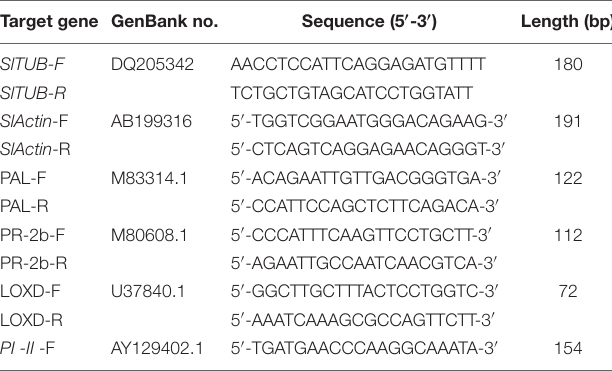
TABLE 1 | Overview of the target genes used in this study, showing their GenBank accession numbers and the primer pair used for qRT-PCR. Target gene GenBank